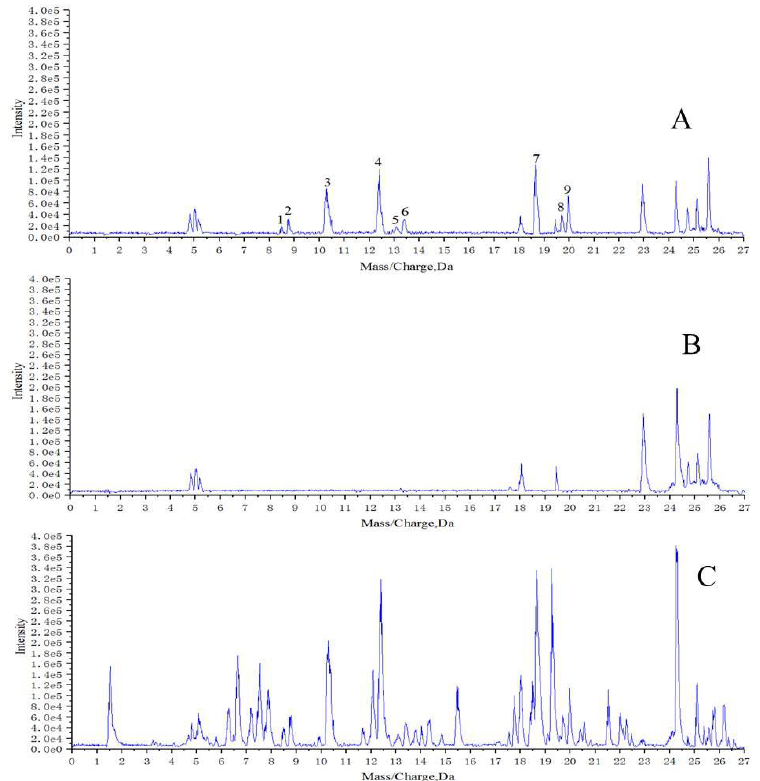
Figure 2. Base peak intensity (BPI) profiles of: ( A ) extract of AH treated with macrophages; ( B ) extract of denatured deposited macrophages; ( C ) ethanol extract of AH.